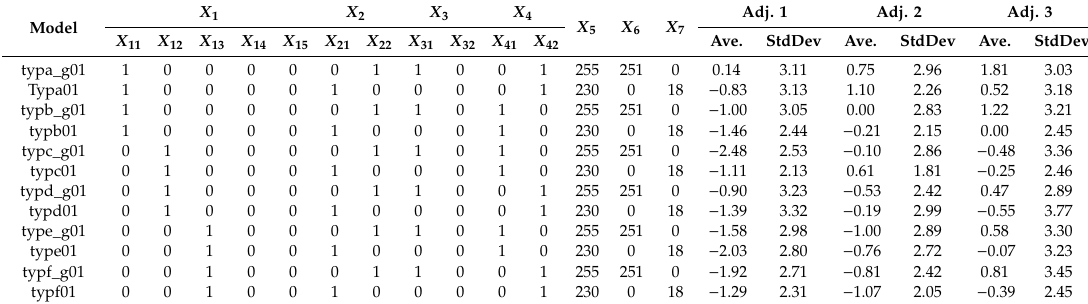
Table 5. Kansei evaluation matrix for 12 selected sports shoe samples.